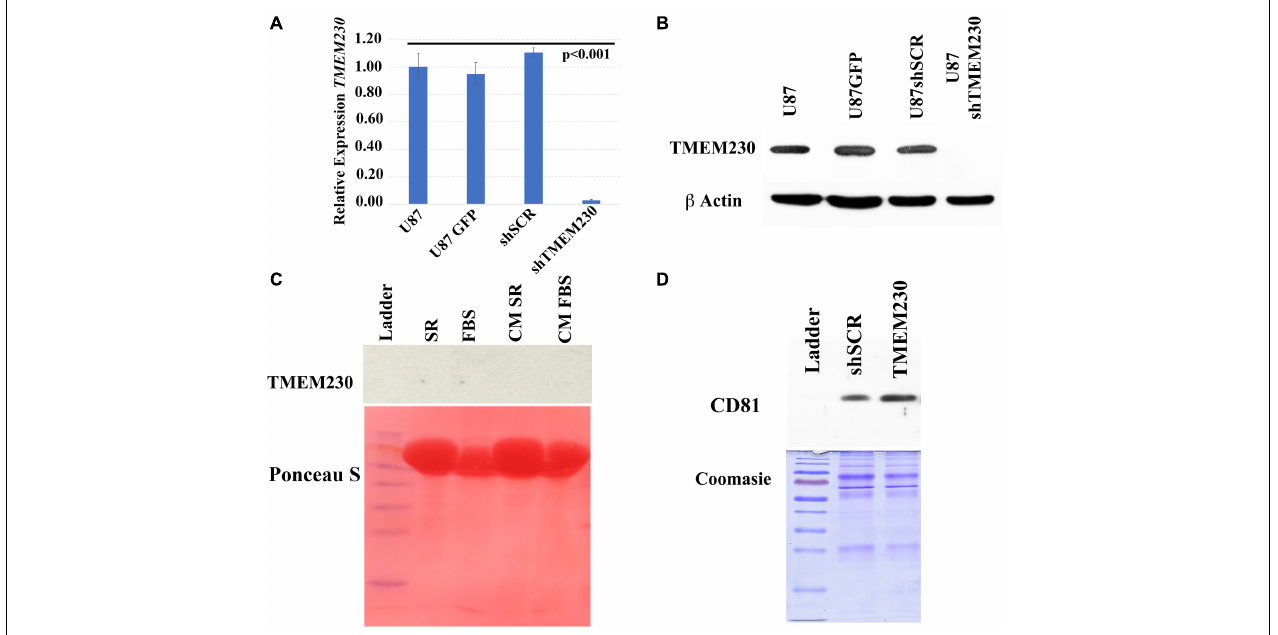
FIGURE 2 | Validation of endogenous and lentivirus downregulation of TMEM230 mRNA and protein expression in U87-MG cells. (A) Validation of constitutive downregulation of endogenous TMEM230 transcript expression with lentiviral system. Endogenous control: HPRT, Error bars represent 95% confidence interval. (B) Validation of constitutive downregulation of endogenous TMEM230 protein expression with the lentiviral system. Endogenous control: β -actin. (C) Western blot analysis (top panel) showed TMEM230 protein was not detected in fetal bovine serum (FBS), serum replacement (SR) or conditioned media (CM) containing serum replacement or FBS (CM SR and CM FBS) obtained from endogenous TMEM230 expressing U87 cells. Ponceau S staining (lower panel) showed an abundance of protein was loaded. (D) Coomassie blue staining showed an increase of expression of extracellular vesicle membrane protein, CD81 in conditioned media of U87 cells constitutively over-expressing TMEM230 with respect to conditioned media collected from control cells (U87GFP and U87shSCR). Detection of CD81 (D) but lack of detection of TMEM230 protein in culture media (C) supports that the TMEM230 protein regulates extracellular vesicle generation or secretion but is not itself a component of extracellular